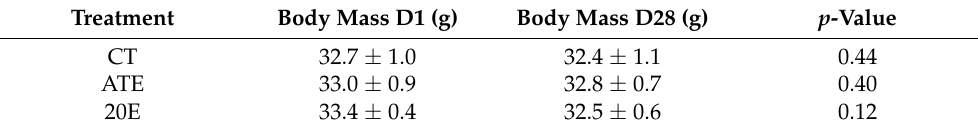
Table 1. Animal body mass by group pre- and post-28-day supplementation period.